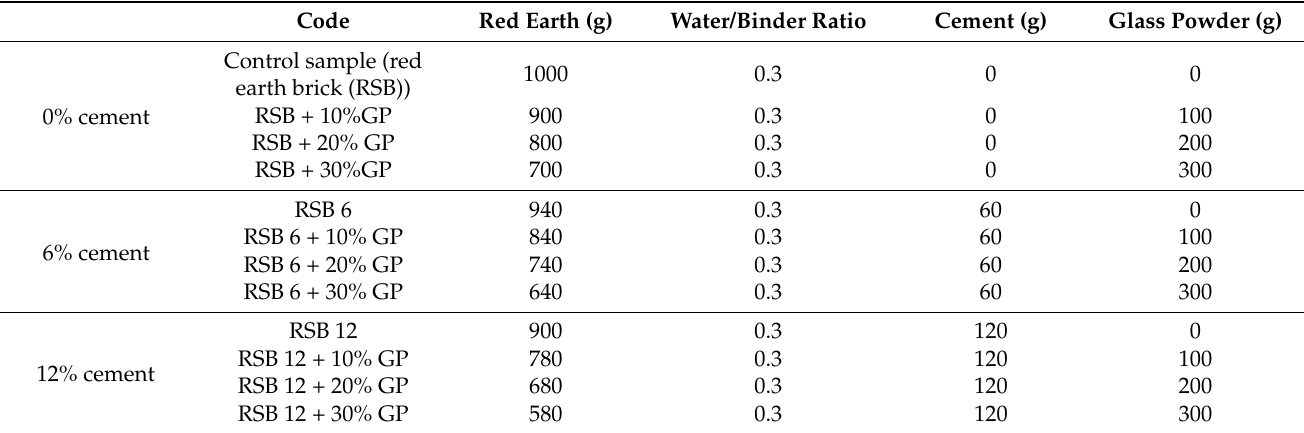
Table 2. Sampling of ternary composite